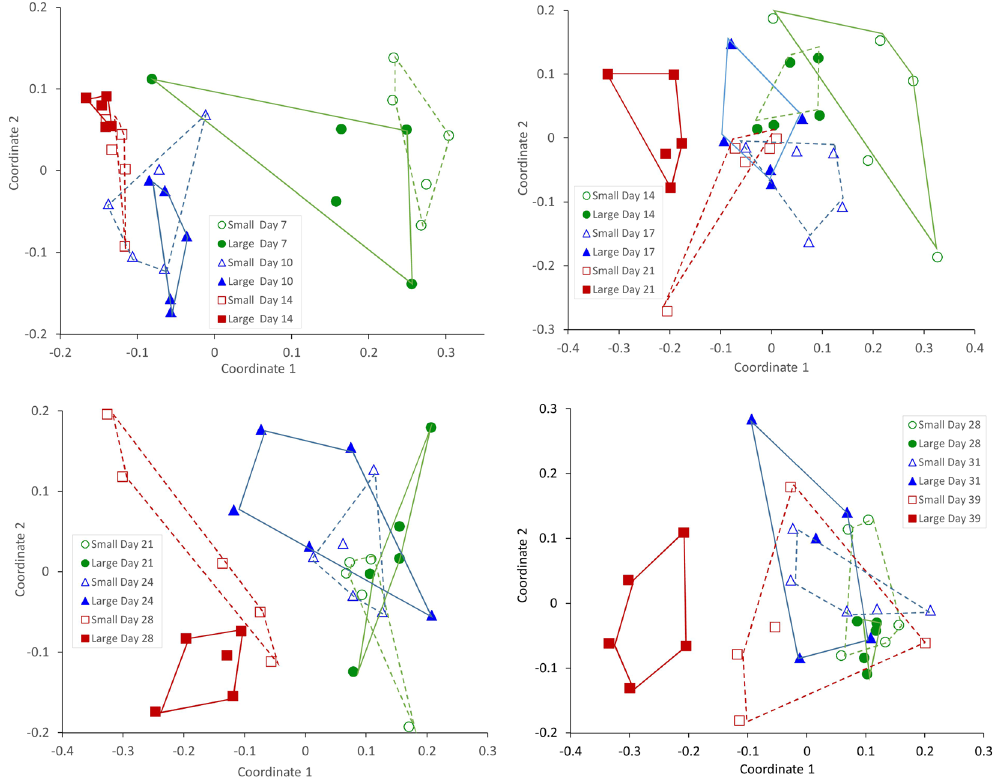
Figure 2. NMDS ordination based on Bray-Curtis similarities for the microbiota of small (S; open symbols) and large (L; filled symbols) larvae for gels 1 to 4. Each symbol represents on individual and the closer symbols are the more similar is their mircrobiota. ( A ) 7 dph (O circle and ● filled circle), 10 dph ( △ triangle and ▲ filled triangle), and 14 dph ( □ square and ■ filled squared); ( B ) 14 dph (O circle and ● filled circle), 17 dph ( △ triangle and ▲ filled triangle), and 21 dph ( □ square and ■ filled squared); ( C ) 21 dph (O circle and ● filled circle), 24 ( △ triangle and ▲ filled triangle) and 28 dph ( □ square and ■ filled squared); ( D ) 28 dph (O circle and ● filled circle), 31dph ( △ triangle and ▲ filled triangle), and 39 dph ( □ square and ■ filled squared).